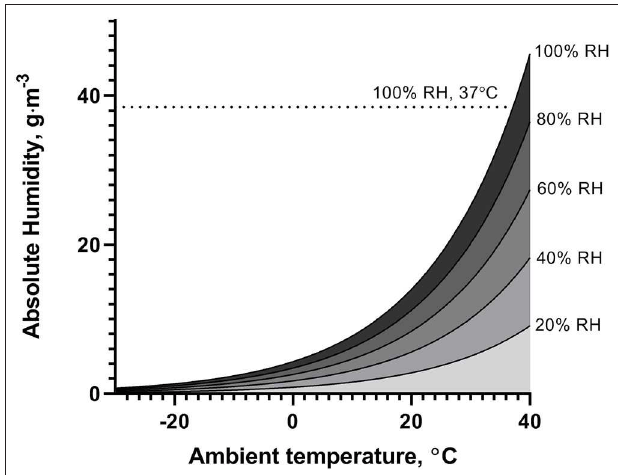
FIGURE 1 | Illustration of absolute humidity of ambient air at temperatures between − 30 and 40 ◦ C, for different levels of relative humidity (RH).